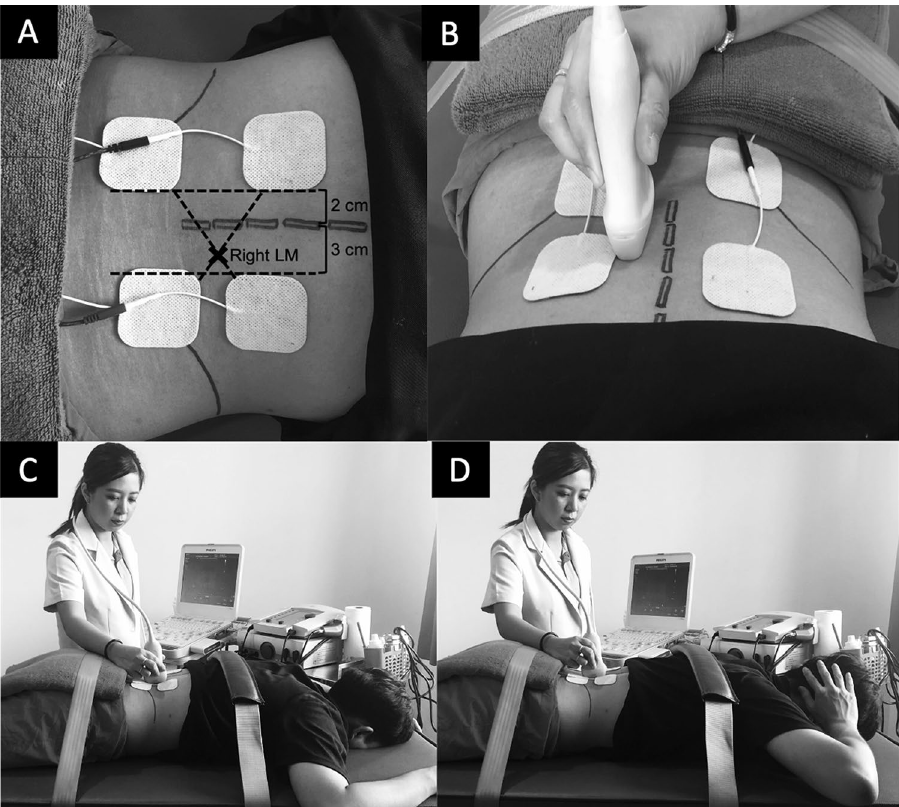
Figure 1. Neuromuscular electrical stimulation placement to stimulate right lumbar multifidus muscle ( A ) and ultrasound transducer placement at right L4-5 facet joint ( B ) during resting ( C ) and maximum voluntary isometric contraction with and without stimulation ( D